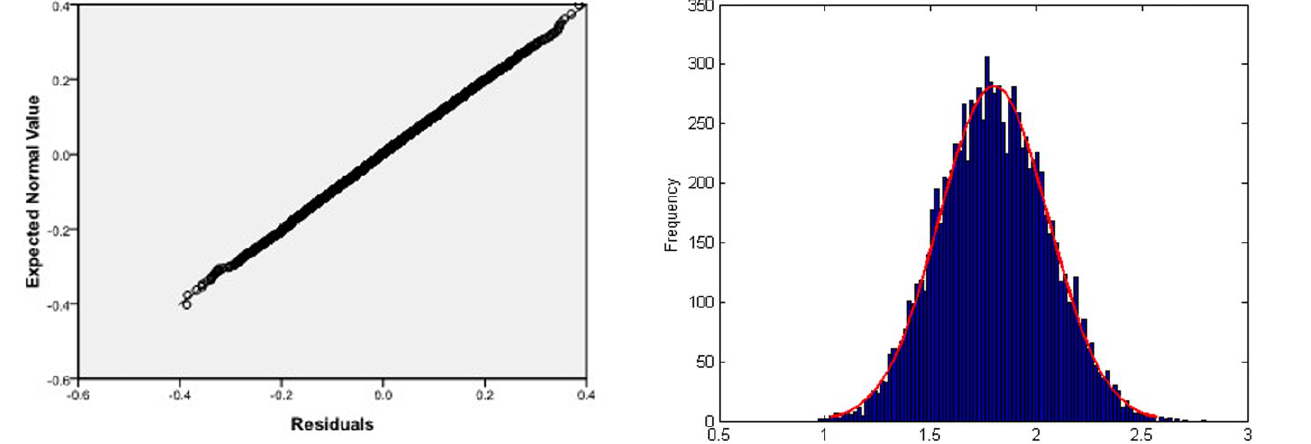
z x 2 )) . Figure 25. Histogram and asymptotic distribution for ^ bb 0 of OLS 1 2 when the variance function of the error term